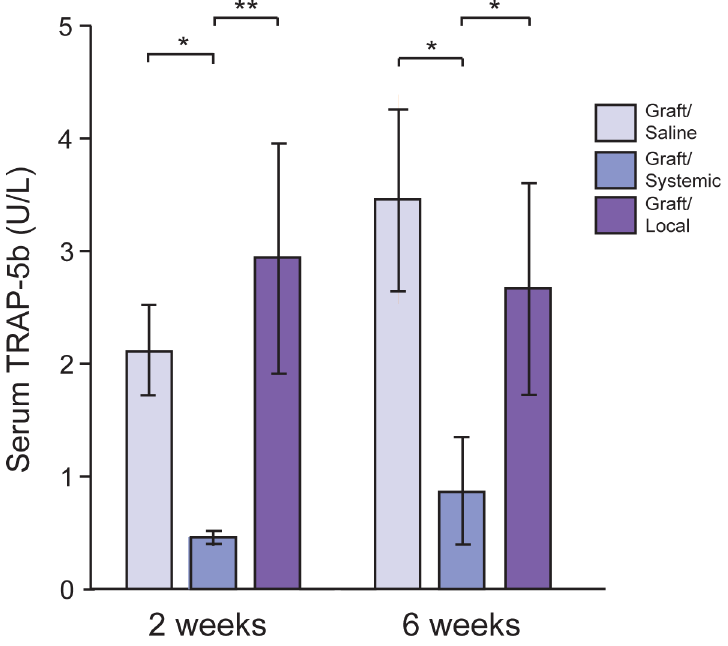
Fig 5. TRAP-5b levels using ELISA assay. Serum TRAP-5b levels analyzedby ELISA assay in the three experimental rat groups at 2 weeks and 6 weeks. * = p < 0.05, ** = p < 0.01. differences in quantity of osteoclasts per bone surface (Oc.N/BS) among the three groups (Fig 4B). TRAP-5b levels were significantly suppressed up to week 6 in the Graft/Systemic group (week 2: 0.46±0.07, week 6: 0.86±0.49U/L), compared to both the Graft/Local and Graft/Saline groups. By contrast, the Graft/Local group (week 2: 2.94±1.01, week 6: 2.67±0.99U/L) had minimal effects on peripheral osteoclast function, as its serum TRAP-5b levels were not signifi-